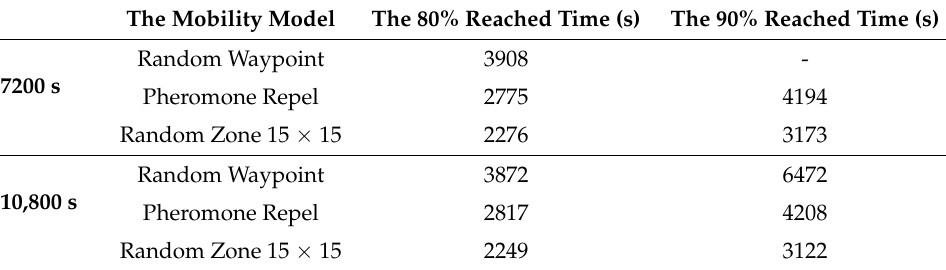
Figure 7. The coverage rate results: ( a ) 7200 s; and ( b ) 10,800 s. Table 5. The 80%- and 90%-coverage reaching time of each